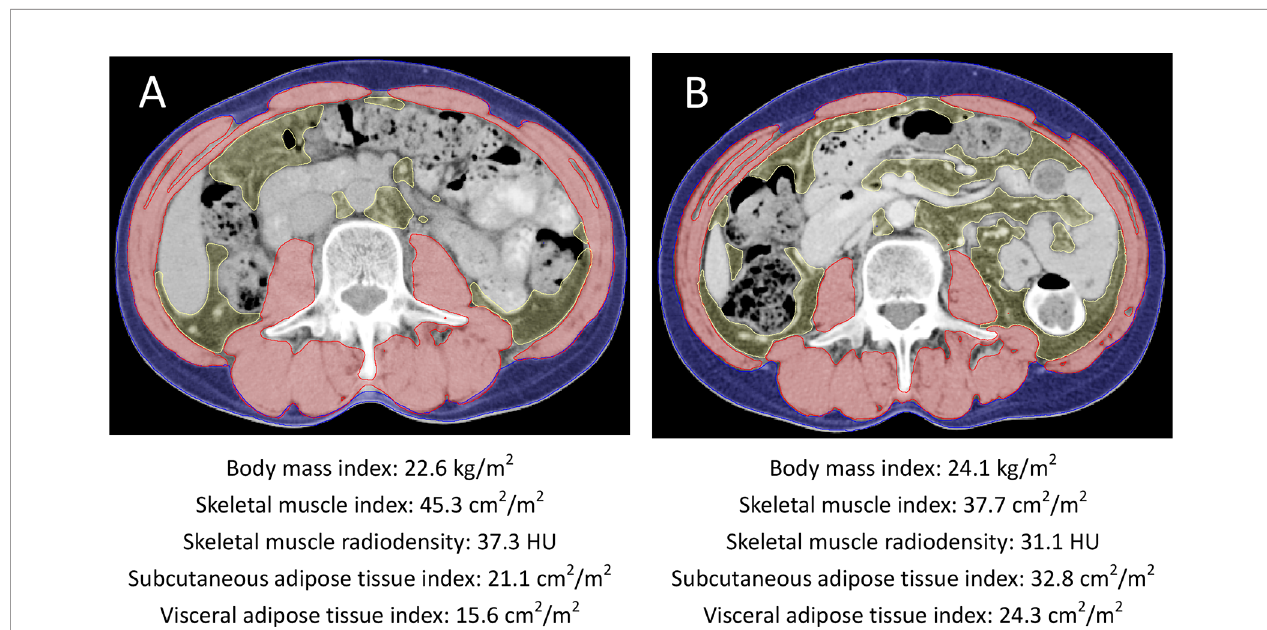
FIGURE 1 | Axial cross-sectional CT images at the L3 vertebral level (A) at baseline and (B) at 6 months after initiation of radiotherapy and androgen deprivation therapy from one patient. The skeletal muscle areas, subcutaneous adipose tissue areas, and visceral adipose tissue areas were outlined in red, blue, and yellow, respectively. This patient had increased body mass index, subcutaneous and visceral adipose tissue indexes and decreased skeletal muscle index during radiotherapy and androgen deprivation